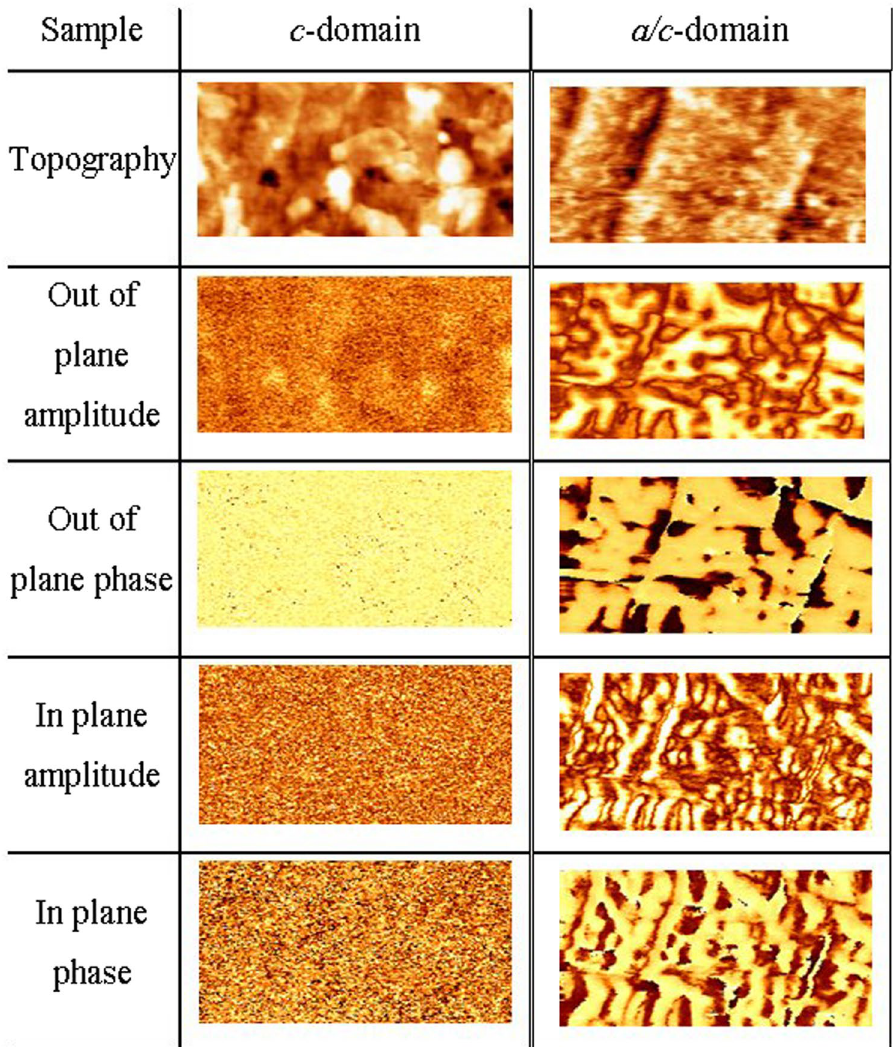
Figure 1. Piezoelectric Force Microscopy (PFM) characterization of the epitaxial PZT thin films. The scan size is 2 μ m × 1 μ m for the c -domain sample and 1 μ m × 0.5 μ m for the a / c -domain